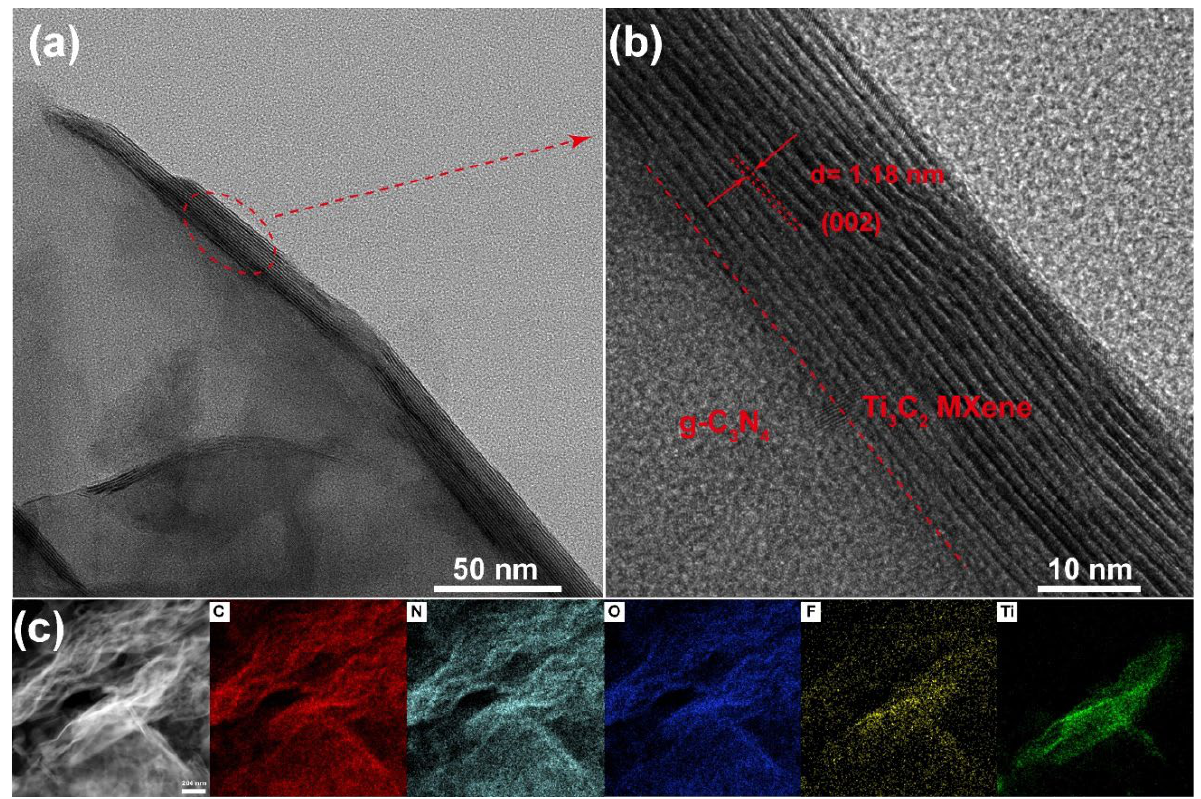
Figure 2. ( a ) TEM image of 2 − TC/CN, ( b ) HRTEM image of 2 − TC/CN, ( c ) EDS mapping images of C, N, O, F, and Ti elements.